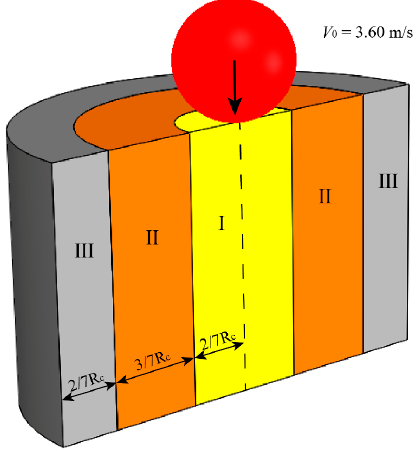
Figure 9. Diagram of sub-region division for granular bed. Region Ⅰ : 0 < R 1 < 2/7 R c ; region Ⅱ : 2/7 R c < R 2 < 5/7 R c ; and region Ⅲ : 5/7 R c < R 3 < R c . (The particles count in one region if their mass centers fall in this region; R c is the radius of the cup).